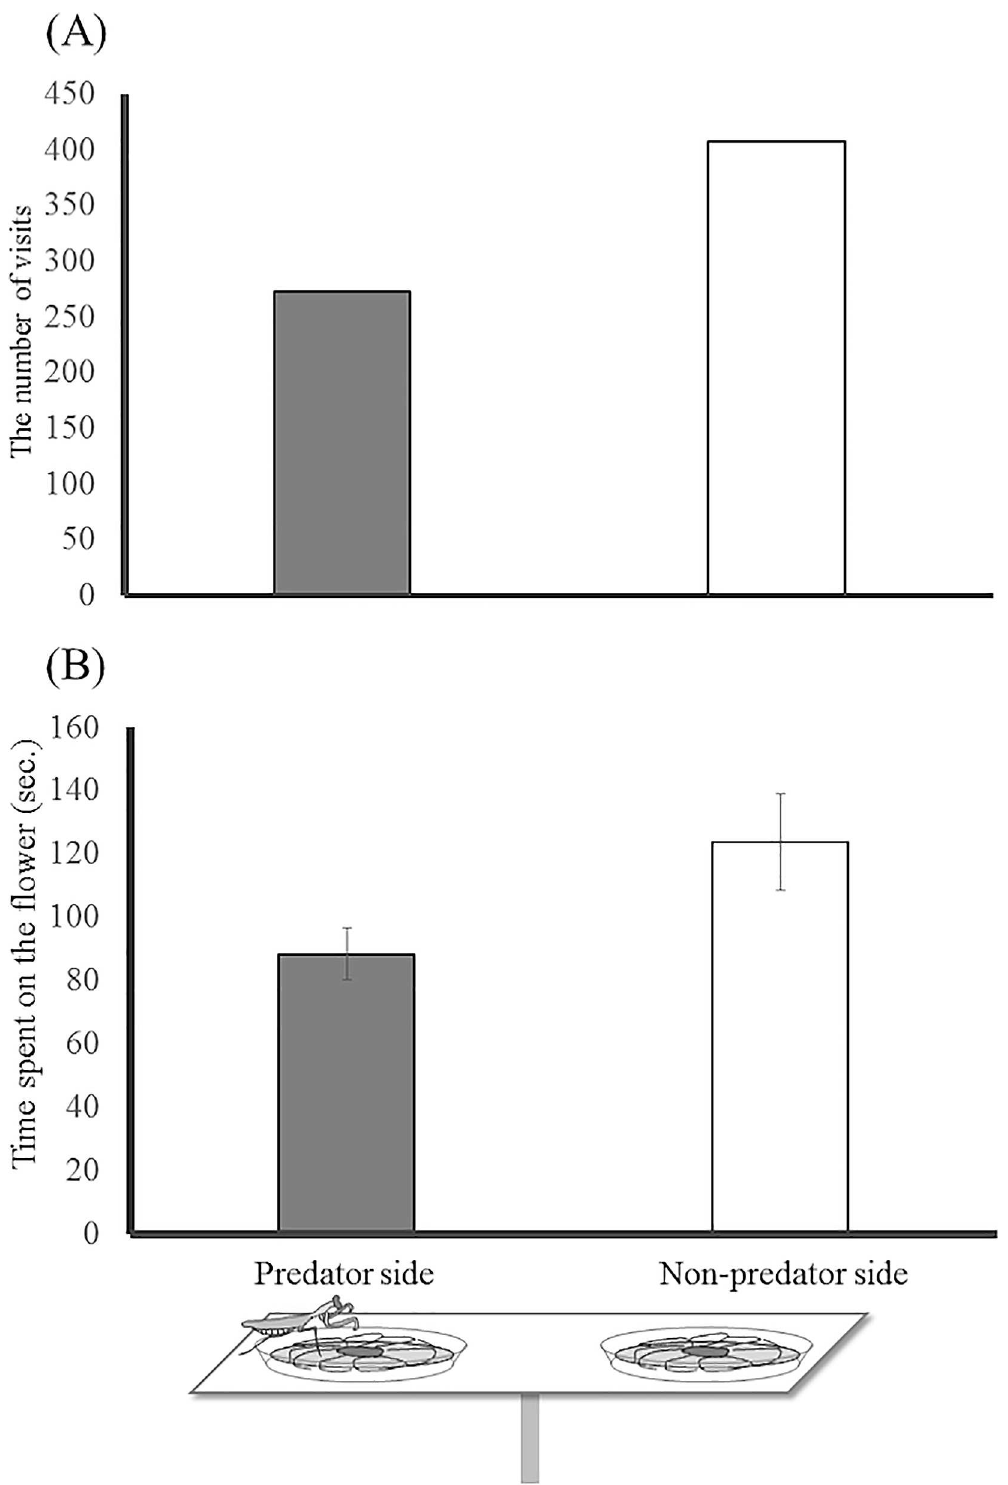
Fig 3. (A) The number of visits and (B) time spent on the artificial flower on the side occupiedor not occupiedby a dried specimenof Tenodera aridifolia (mean ± SE).